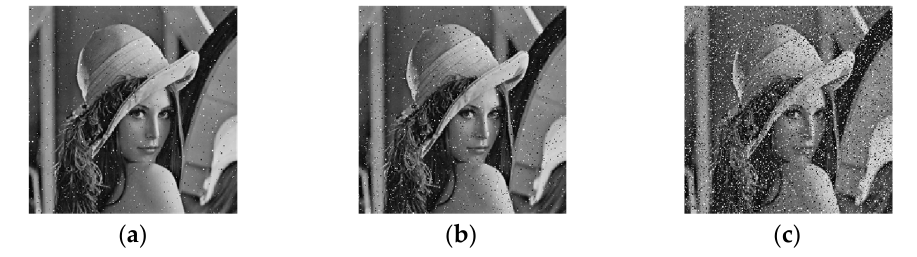
Figure 11. Noise attack. Noise strength ( a ) 0.005; ( b ) 0.01; ( c ) 0.05.